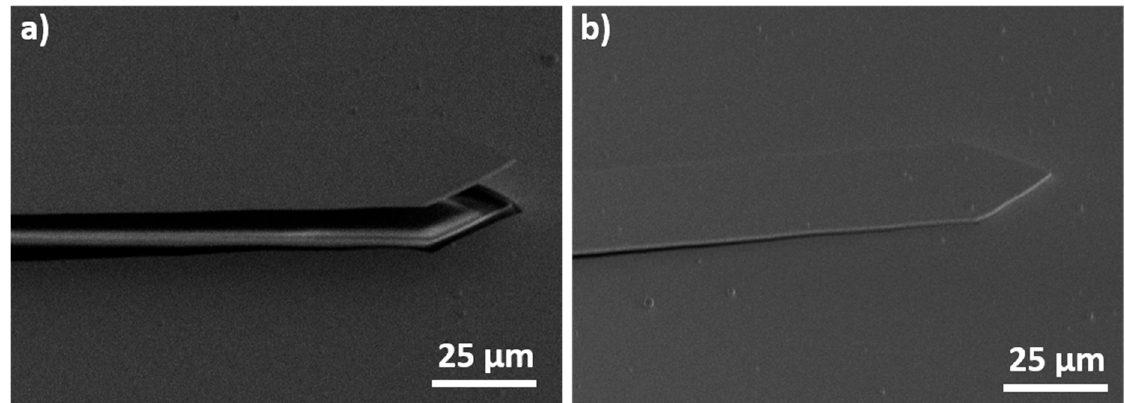
Figure 5. SEM tilted views of cantilevers in the resin after the deposition of the titanium/copper layers by ( a ) sputtering and ( b ) evaporation under vacuum.